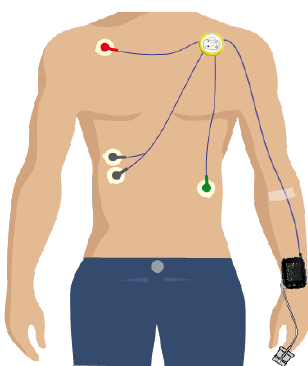
Figure 1. A scheme illustrating the allocation spots of SOMNOtouch-NIBP device and electrodes (Received from Somnomedics http://www.somnomedics.eu).